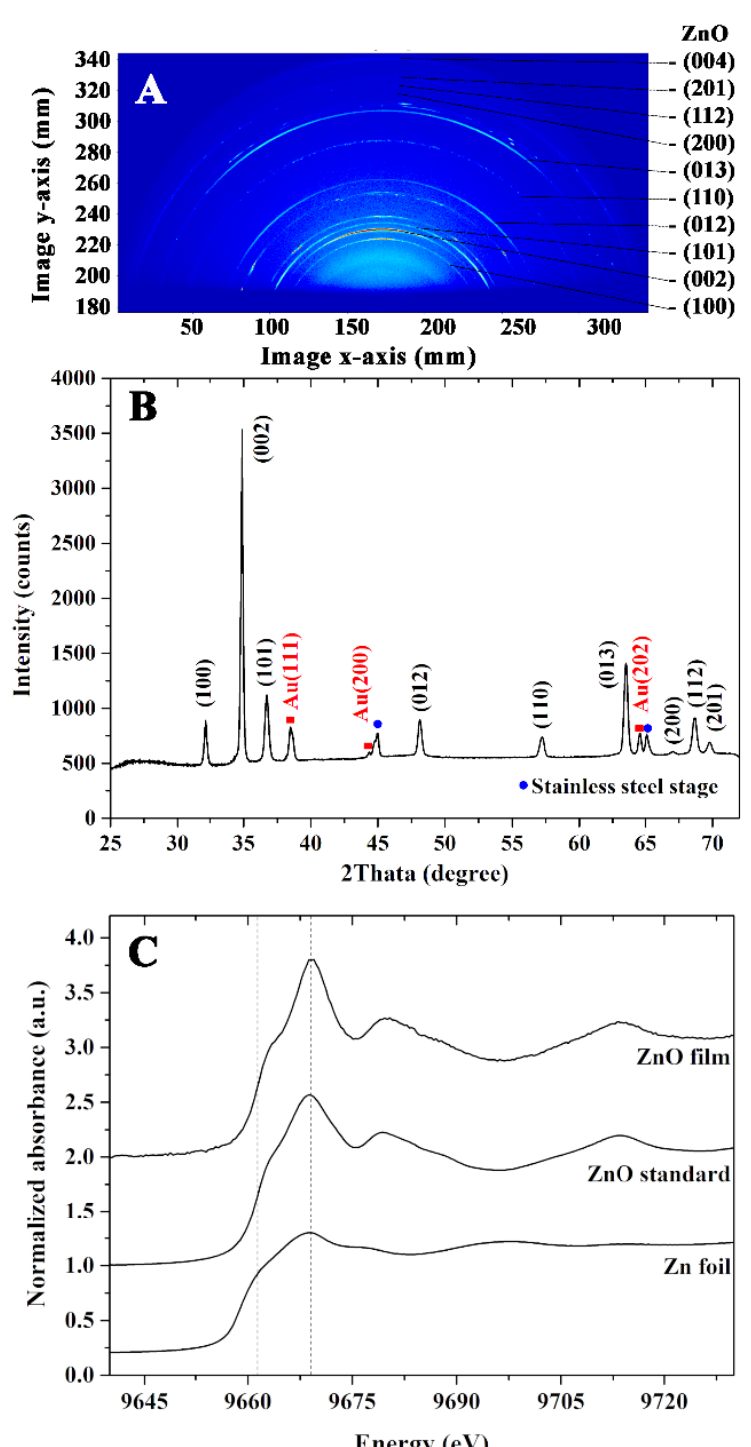
Figure 3. ( A ) WAXS patterns, ( B ) X-ray diffraction pattern, and ( C ) normalized Zn K-edge XANES of the ZnO nanorods thin film.